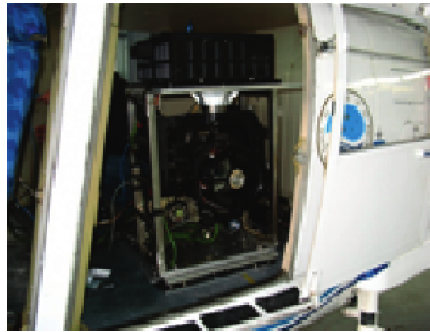
Figure 14: Setting of the airborne motion